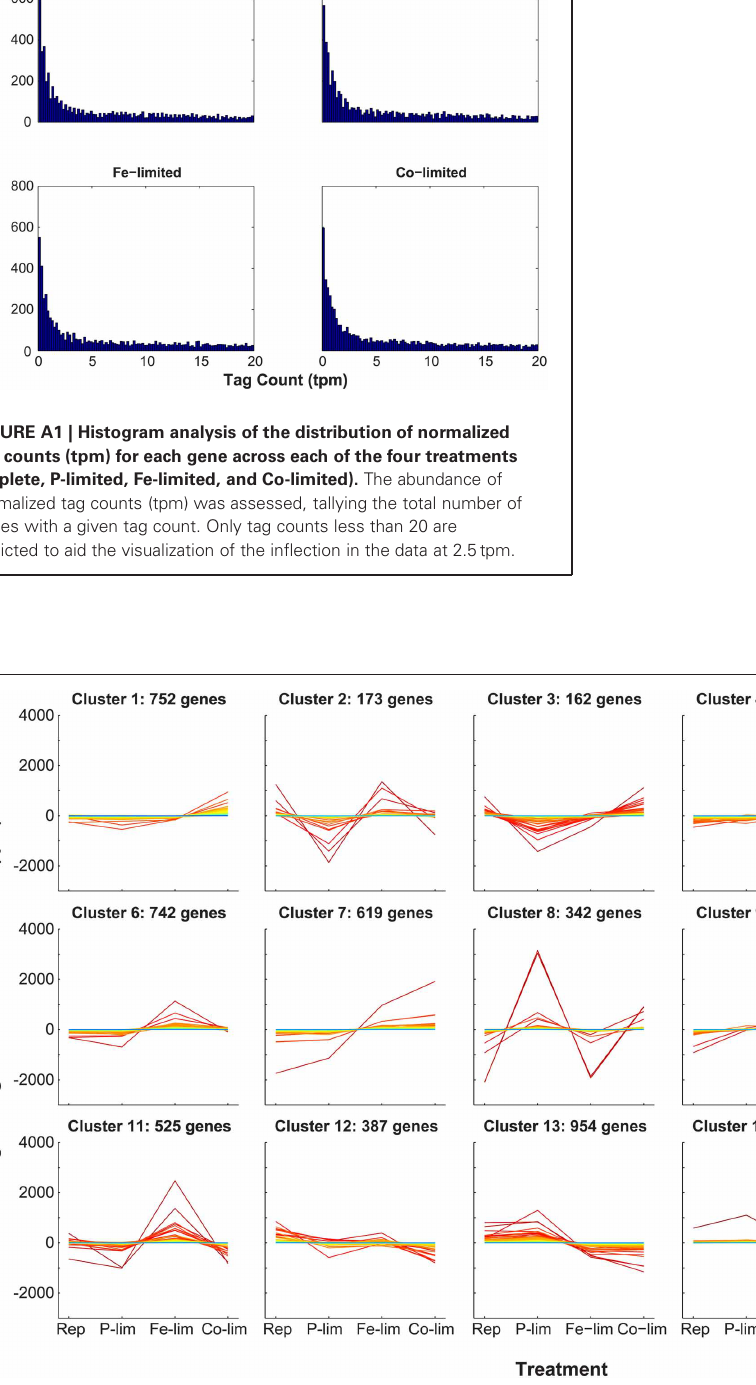
normalized to total library size (in tpm) for each gene are plotted relative to the mean (indicated by the color of the line) for each of the four treatments: Replete (Rep), P-limited (P-lim), Fe-limited (Fe-lim), and Co-limited